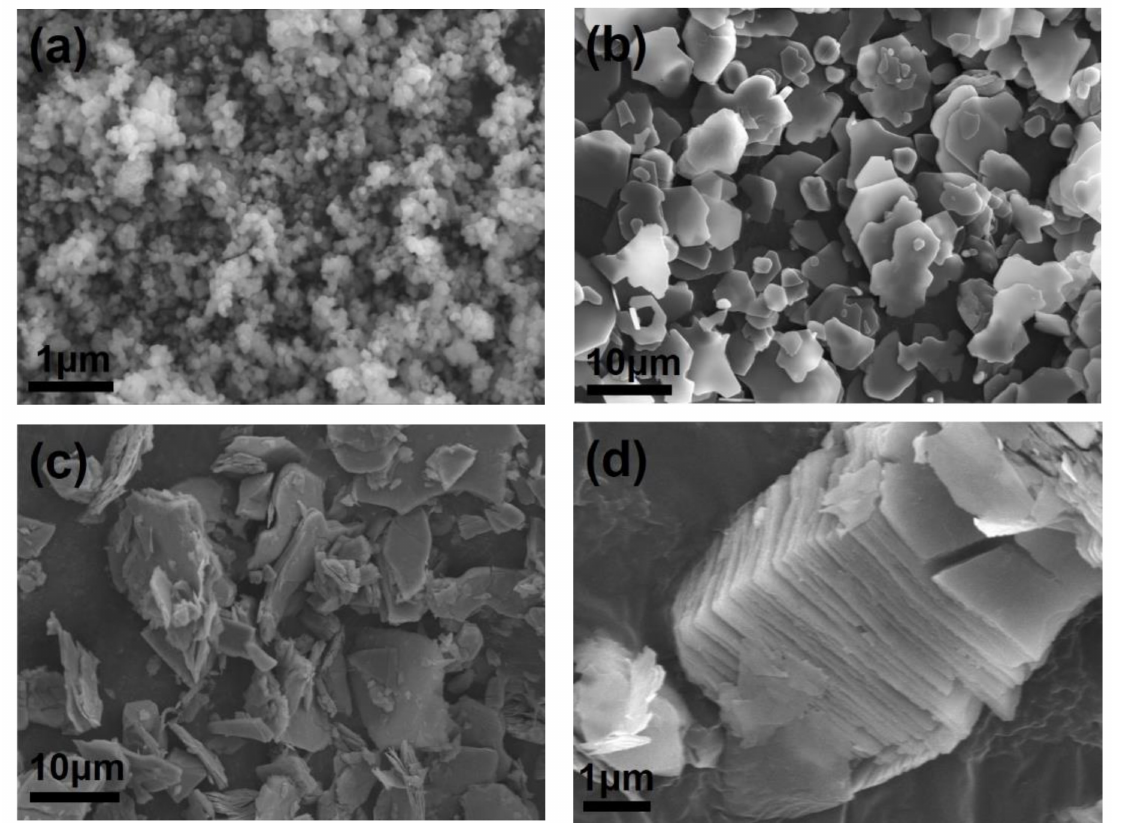
Figure 3. SEM images of additives, ( a ) 3Y-ZrO 2 ; ( b ) Al 2 O 3 platelet; ( c , d ) Ti 3 C 2 T x MXene. The fracture surface images were used for comparative analysis of the grain size evolution depending on additives incorporated in alumina matrix. As displayed in Figure 4, the fracture surface morphology varies greatly with the additives. It is revealed that the grain size distribution is not uniform for the monolith Al 2 O 3 (A1, Figure 4a). However, when ZrO 2 is added, the grain size become smaller (A2, Figure 4b). For A3 as shown in Figure 4c, the grains are still very small, and the edges after fractured are much clearer. Notably, the number of large grains becomes less in comparison with A2. When Al 2 O 3 platelet is added, surprisingly, the Al 2 O 3 grains are elongated, with a very high length- width ratio (Figure 4d,e). In comparison with A5, the layered structure of A4 is more regular. The thickness of the elongated Al 2 O 3 grains in A5 is thinner, and their arrangement is more disorder. Based on the above observation, the addition of additives has a great influence on the morphology evolution of the samples, thus affect their mechanical